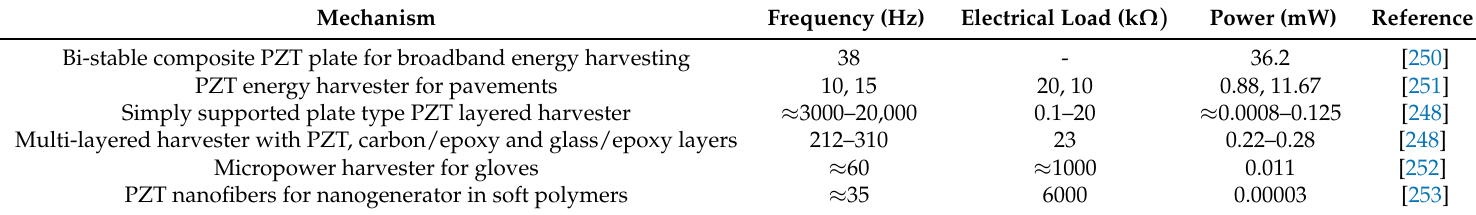
Table 6. Comparison of various cantilever-based